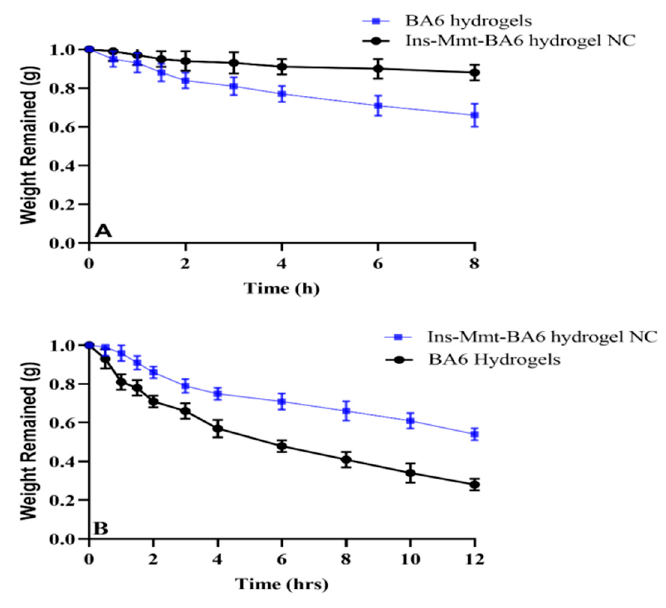
Figure 13. Biodegradation studies at pH 1.2 ( A ) and pH 7.4 ( B